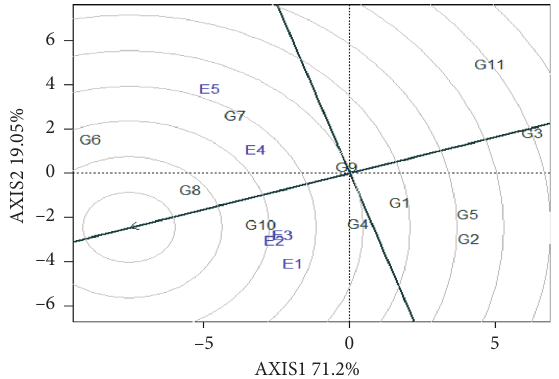
Figure 5: The average-environment coordination (AEC) view to rank genotypes relative to an ideal genotype. The biplot based on scaling � 0; centering � 2; SVP � 1; genotypes: G1 � 95/0194,